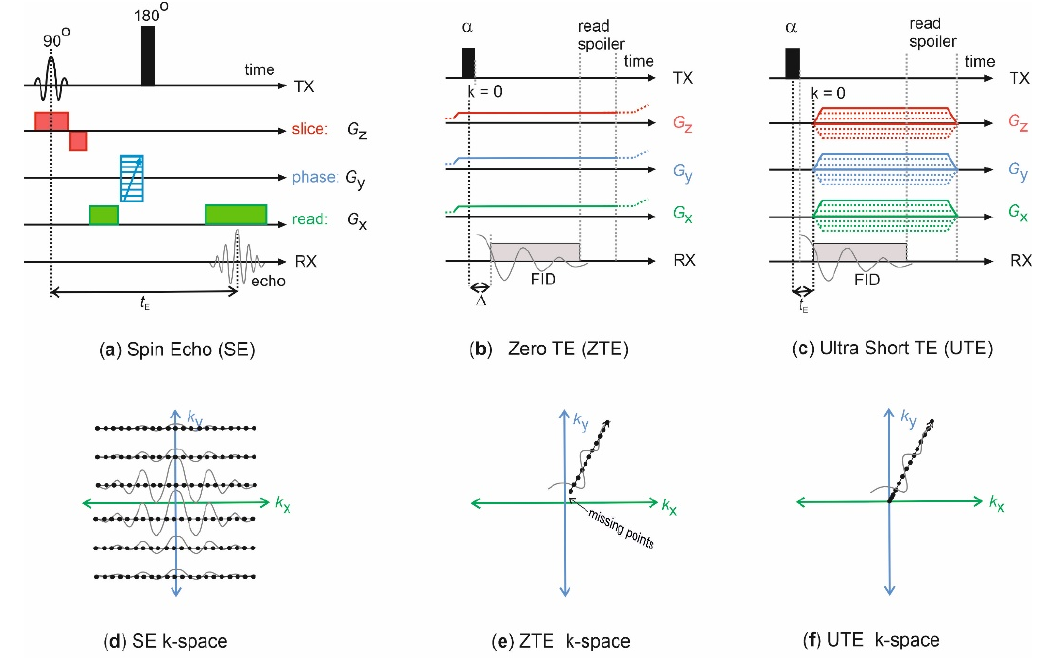
Figure 7. Simplified MRI pulse sequence diagrams. ( a ) Spin-echo (SE) sequence, also termed multislice multiecho sequence (MSME), if more than one echo more recorded per excitation and phase-encoding step. A combination of the 90 ◦ rf pulse with the slice gradient G z excites an individual slice, the 180 ◦ rf pulse refocuses the dephased magnetization in the xy -plane and creates an echo after echo time t E , which is read-out in presence of the read gradient G x and stored. The phase gradient G y encodes the 3rd dimension. Thus, the corresponding k -space ( d ) is filled in Cartesian coordinates. ( b ) In the ZTE sequence a non-slice selective hard rf -pulse excites the spin system with a flip angle α after the three spatially encoding gradients, G x , G y , and G z have been switched on. Instead of an echo, the FID is monitored by n acq complex data points after the dead time ∆ . Different combinations of the gradients separated by the spoiling time achieve spatial encoding. ( e ) The k -space is filled radially, shown is one exemplary projection line. ( c ) In the UTE sequence a non-slice selective hard rf -pulse excites the spin system with a flip angle α before the three spatially encoding gradients, G x , G y , and G z are switched on. Like in ZTE, the FID is monitored and stored, and space is encoded by different combinations of the gradients. ( f ) The k -space is filled radially.